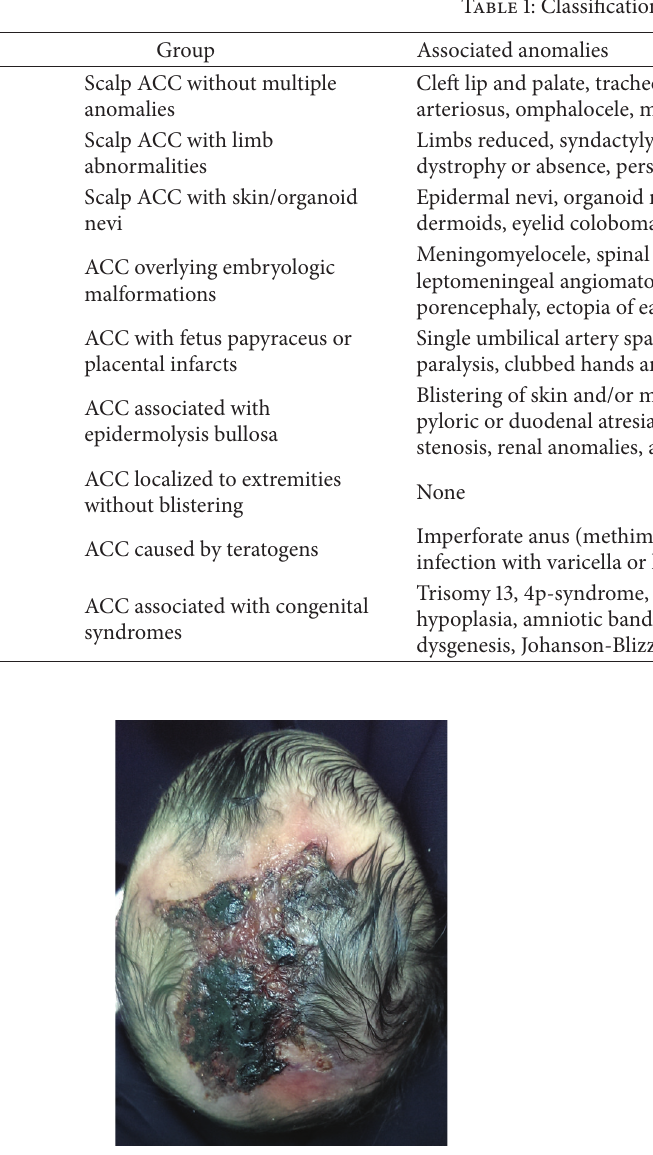
Figure 1: The newborn presented with skin defect of the scalp with an overlying crust.